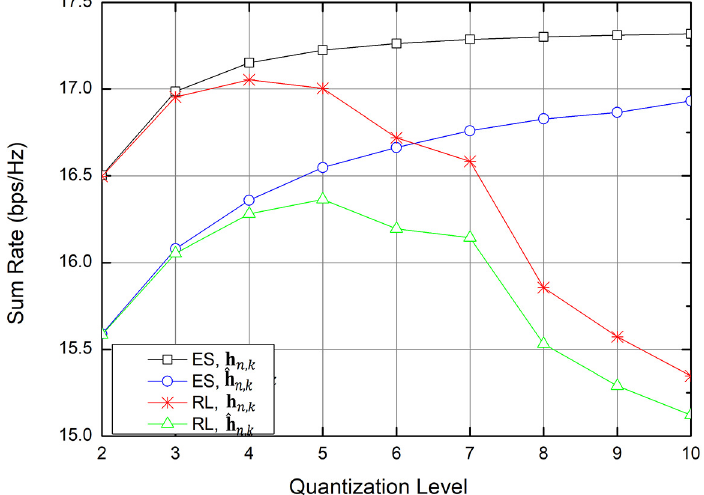
Figure 4. Sum rate versus the number of channel state information (CSI) quantization levels when the time slot is